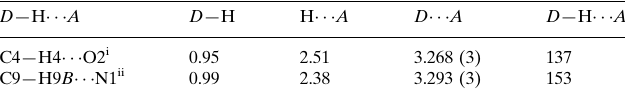
Hydrogen-bond geometry (A˚ , (cid:1)